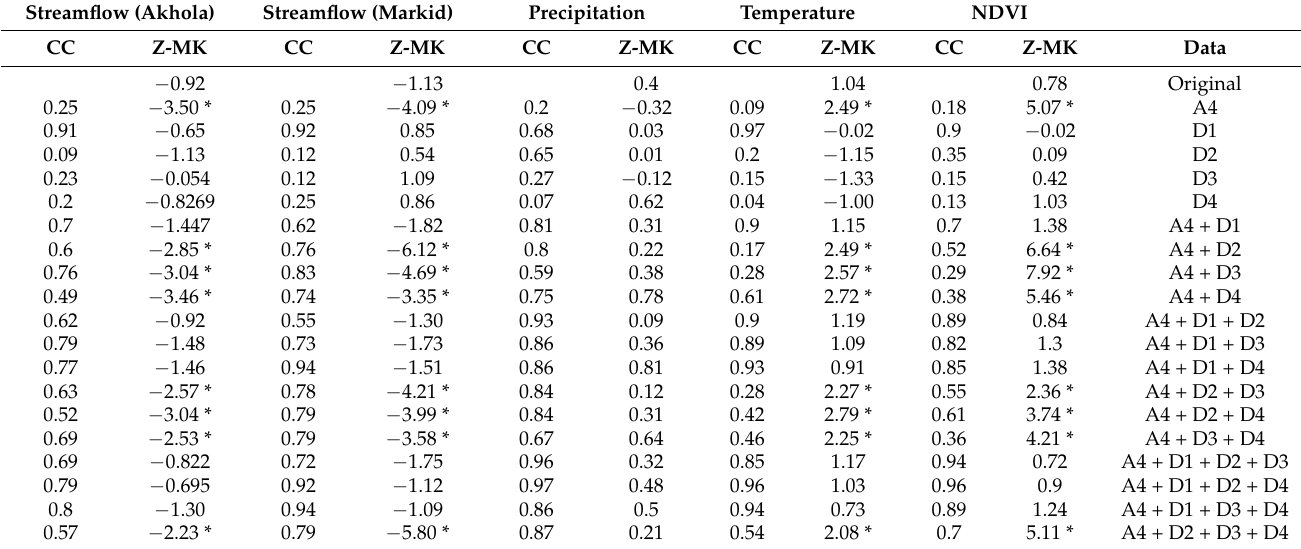
Table 6. Mann–Kendall Z-values and correlation coefficients of seasonal time